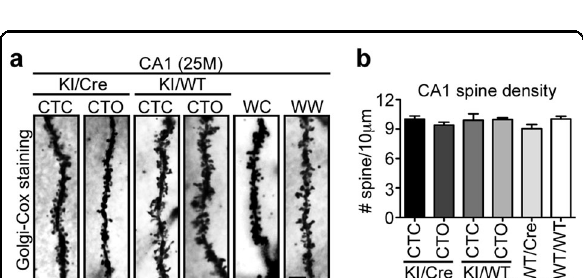
Fig. 4 Dendritic spine density is maintained in the hippocampus of old CTC KI/Cre mice. a Representative micrographs of Golgi-cox staining and b quanti fi cation of dendritic spine density in hippocampal CA1 sections from 25-month-old CTC KI/Cre ( n = 3), CTO KI/Cre ( n = 5), CTC KI/WT ( n = 4), CTO KI/WT ( n = 4), WT/Cre ( n = 5), and WT/WT ( n = 4). WC: WT/Cre, WW: WT/WT. Data represent the mean ± SEM. One-way ANOVA followed by Bonferroni ’ s